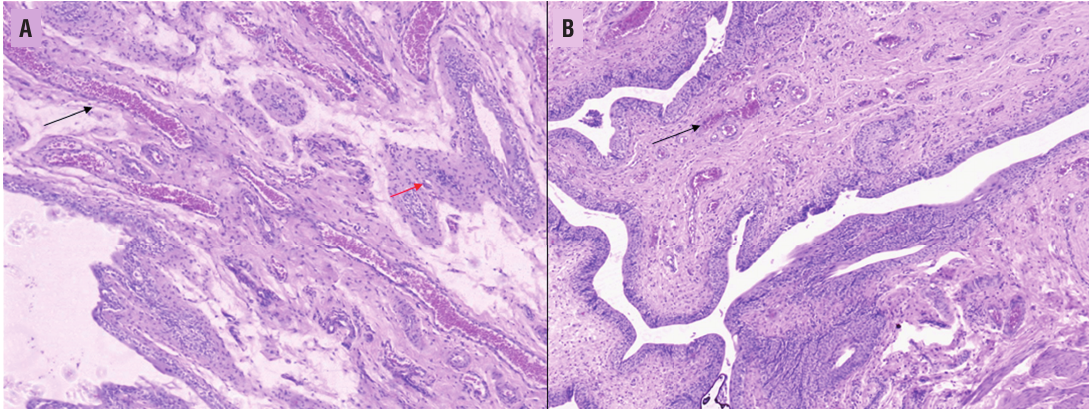
Figure 2 – Histopathological slide of a rat urinary bladder from both the control (A) and copaiba (B) group. Note the vascular congestion and proliferation (black arrows) and the giant cell reaction (red arrow). Hematoxylin/Eosin stain 20x.